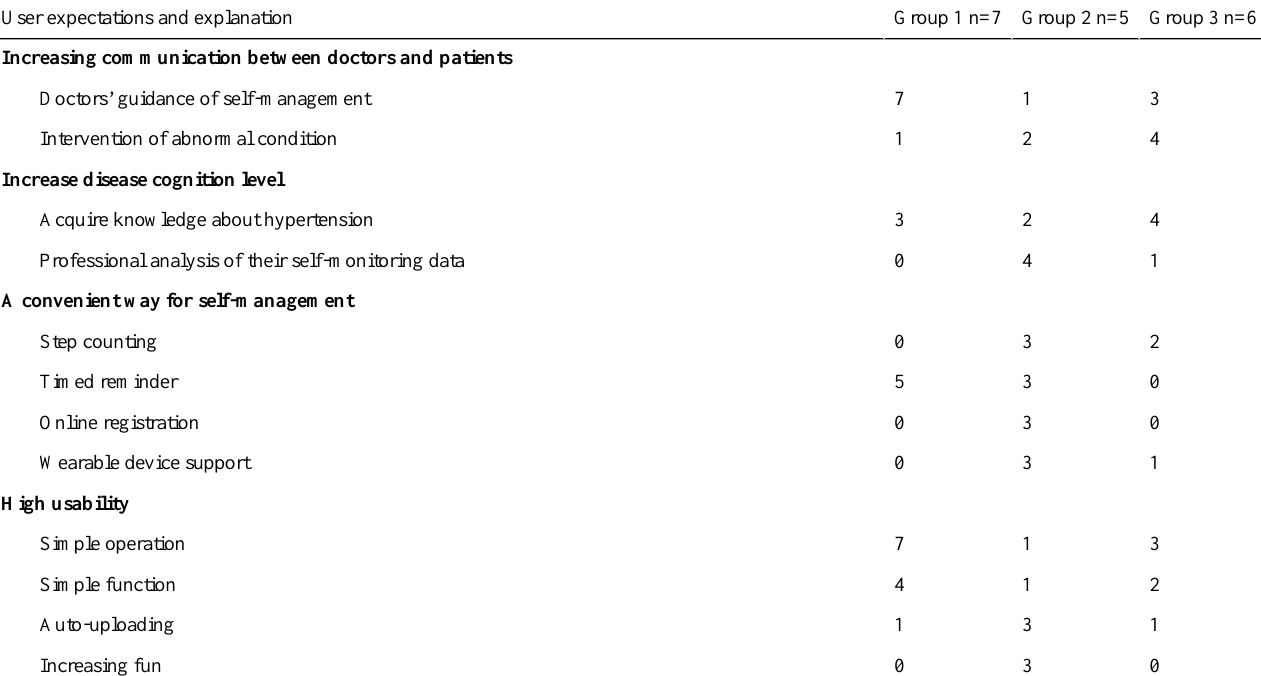
Table 3. Interview coding